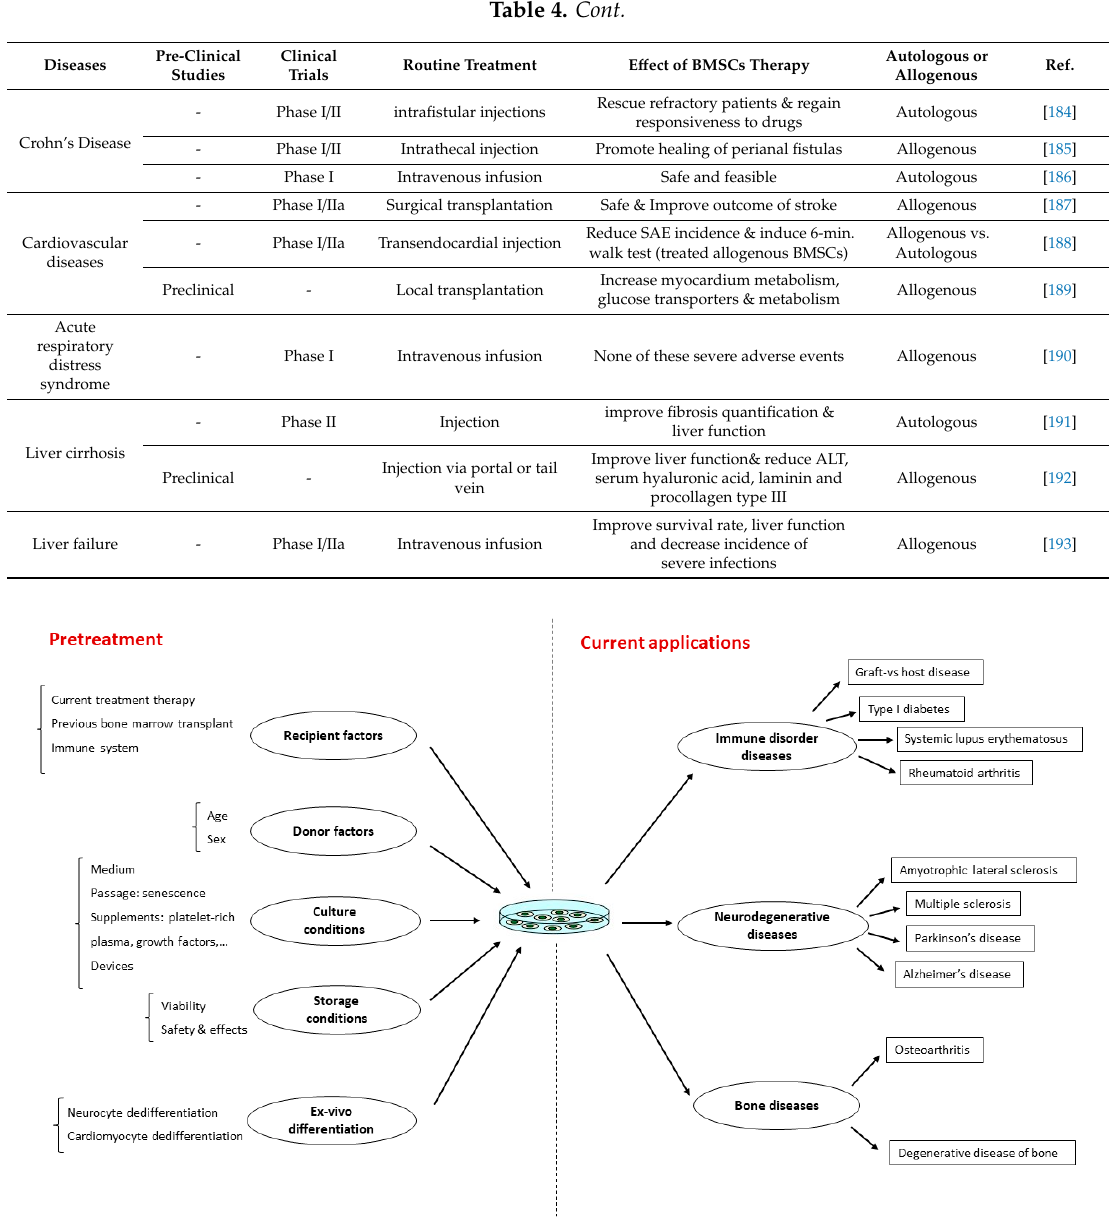
Figure 3. Summarize the current clinical applications of bone marrow mesenchymal stem cells. Table 4. Preclinical studies and clinical trials of bone marrow stem cells (BMSCs) applications.